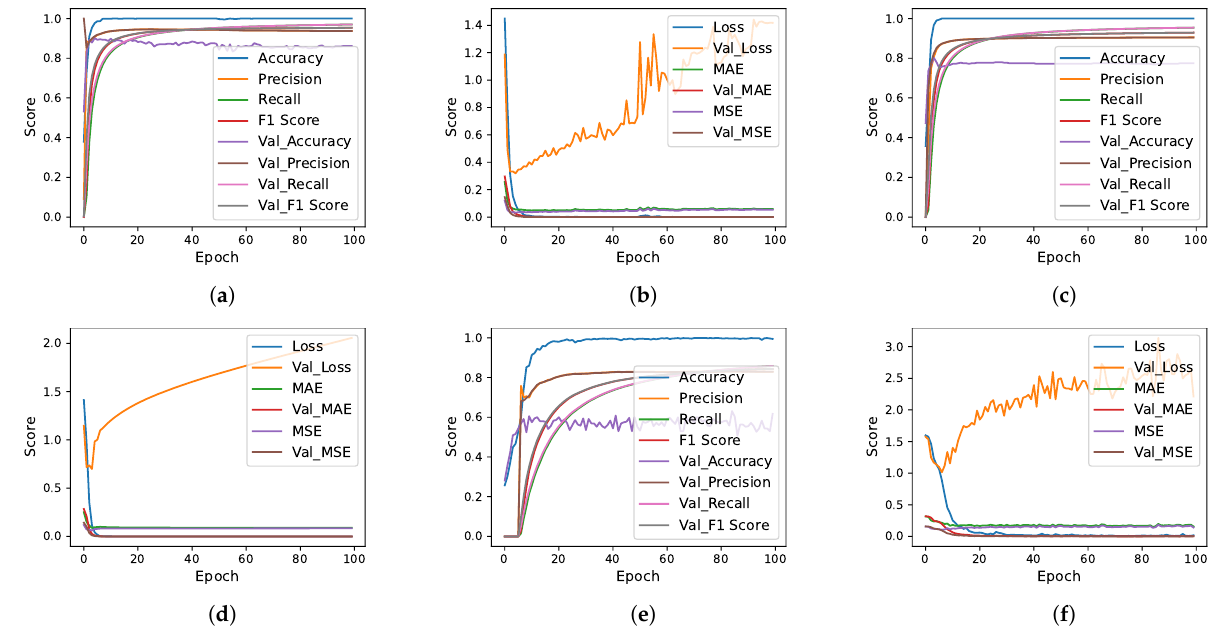
Figure 8. Deep learning models per epochs evaluation scores using FFS. ( a ) CNN accuracy using FFS, ( b ) CNN loss using FFS, ( c ) CNN-LSTM accuracy using FFS, ( d ) CNN-LSTM loss using FFS, ( e ) LSTM accuracy using FFS and ( f ) LSTM loss using FFS.